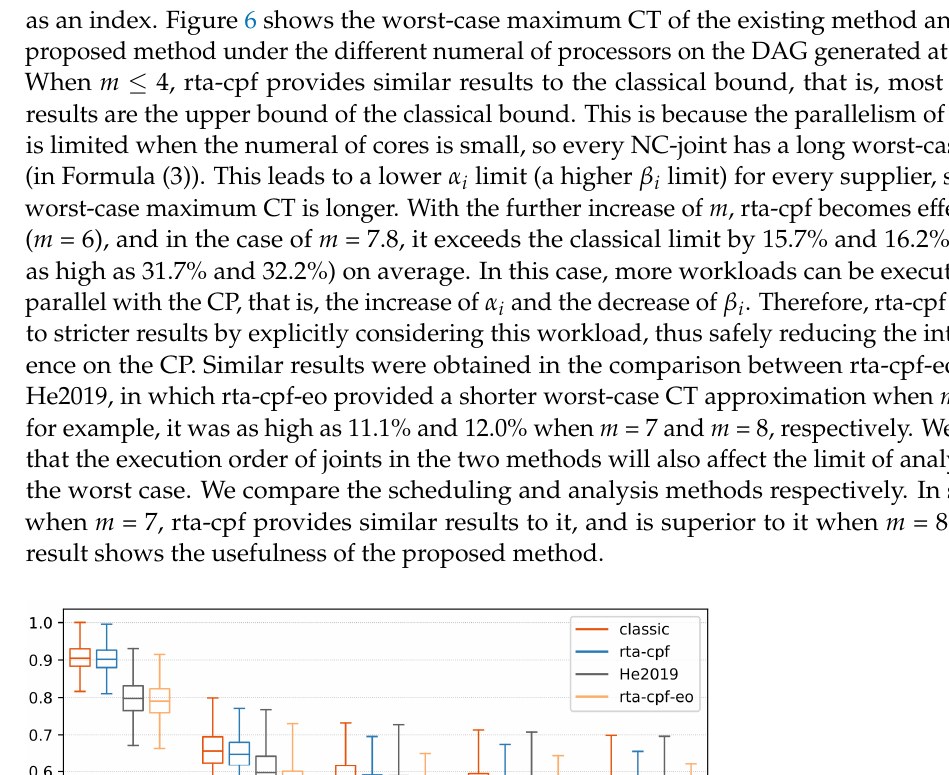
Figure 7. Sensitivity of parallelism parameter ( m = 4).